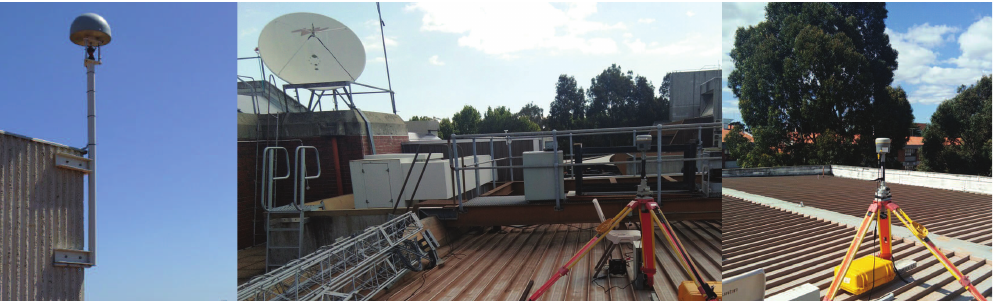
Figure 1. Rover receivers in: ( left ) the open-sky scenario and ( middle and right ) the suburban scenario. Table 1. Receiver and antenna types of the two baselines used in data